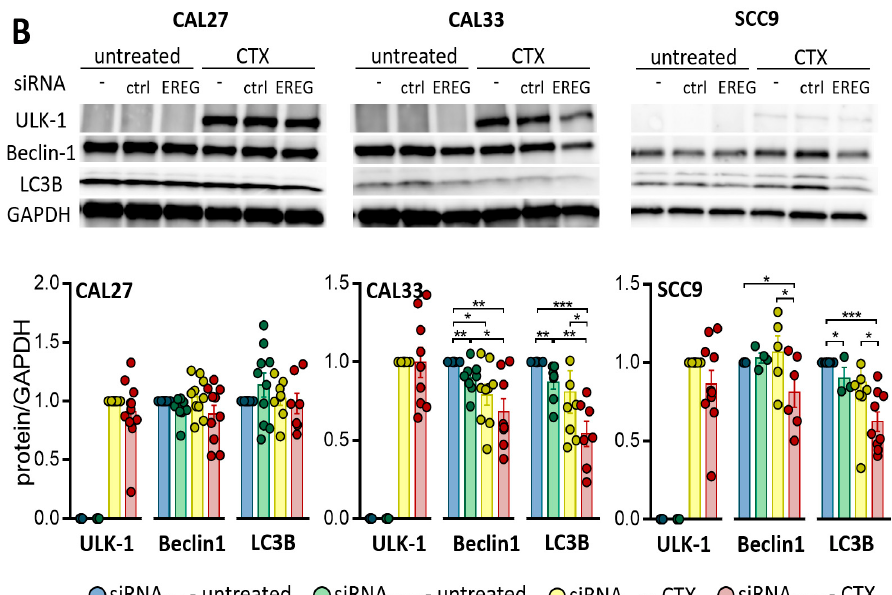
Figure 2. ( A ) Energetic map of CAL27, CAL33 and SCC9 cells transfected with siRNA Ctrl or siRNA EREG and treated with solvent or 30 nM CTX. Histograms show the ATP production of CAL27, CAL33 and SCC9 cells transfected with siRNA Ctrl or siRNA EREG and treated with solvent or 30 nM CTX. Data are represented as the mean ± SEM of ATP produced 144 h post-transfection and post-treatment ( n = 8–9, with * p < 0.05, ** p < 0.001 and *** p < 0.0001). ( B ) Expression of ULK-1, Beclin1, LC3B and GAPDH was determined by Western blot in CAL27, CAL33 and SCC9 cells not transfected or transfected with siRNA Ctrl or siRNA EREG and treated with solvent or 30 nM CTX. Histograms represent the mean ± SEM (CAL27 n = 11, CAL33 n = 9 and SCC9 n = 10, with * p < 0.05, ** p < 0.01 and *** p < 0.001) of the protein expression normalized with GAPDH.